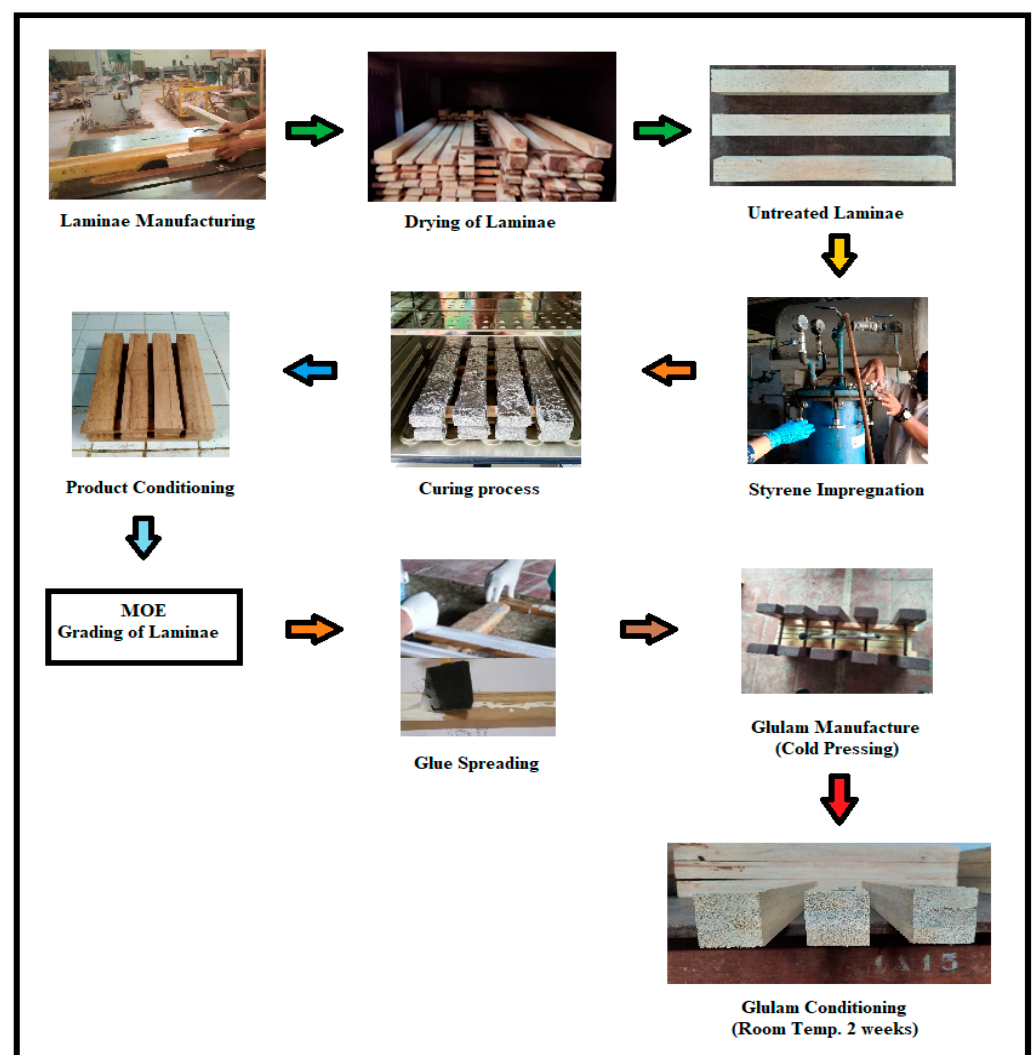
Figure 1. Laminae and glulam manufacturing